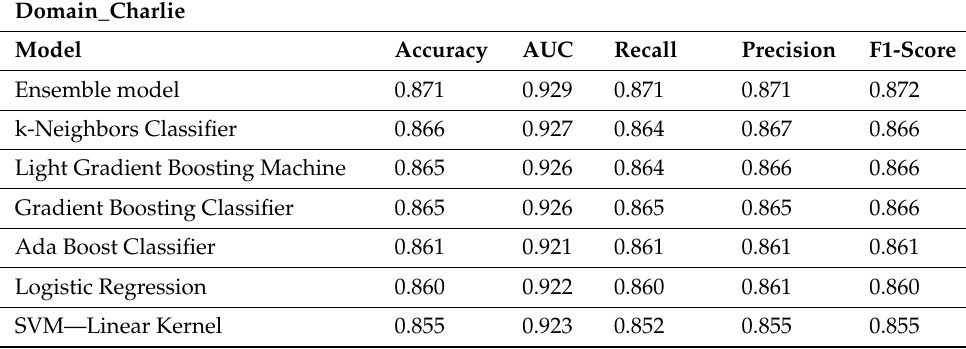
Table 9. Ensemble model for the Domain